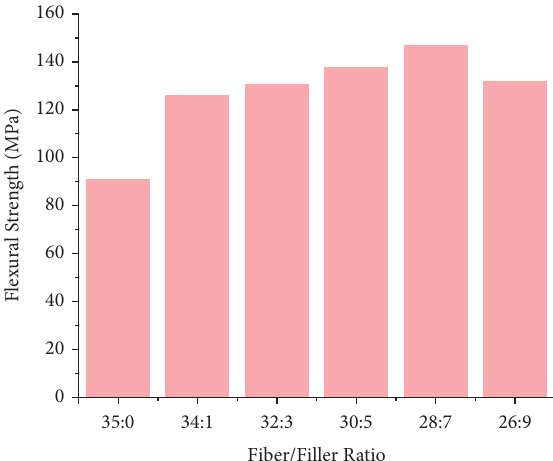
Figure 8: Epoxy resin/madar fibre/sugarcane bagasse ash com- posites: effect of fibre/filler loading on flexural